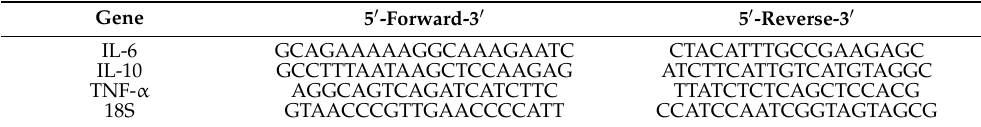
Table 10. List of primers (Sigma-Aldrich Life Science Co. LLC., U.S.A.) utilized in the present study.